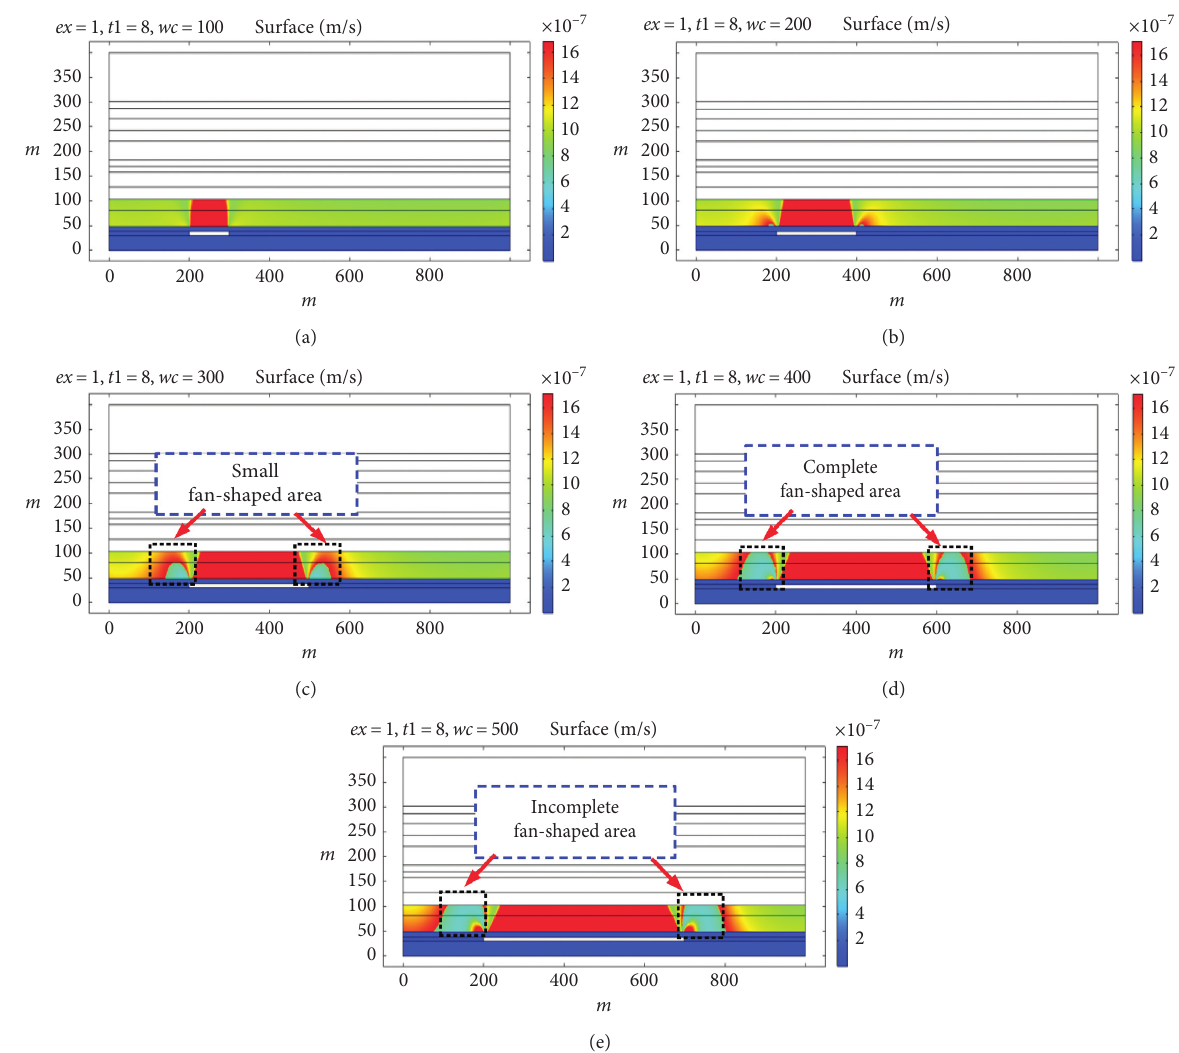
Figure 6: Variation of permeability coefficient at different depth in a coal seam of 8 m in thickness. (a) The depth of 100 m.(b) The depth of 200m. (c) The depth of 300m.(d) The depth of 400m. (e) The depth of